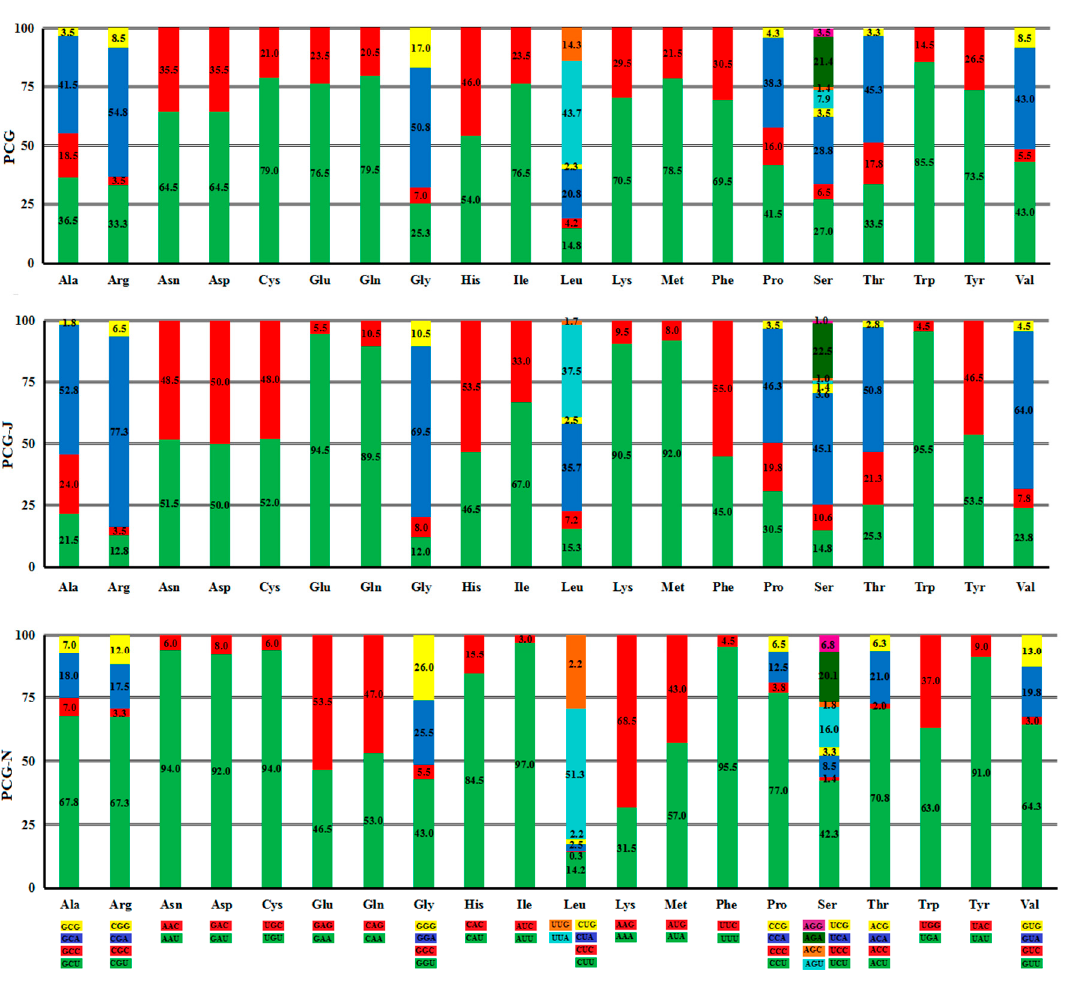
Figure 1. Percentage of synonymous codon usage of each amino acid in the ten Tenebrionidae mitogenomes. Codon families were provided on the x -axis.